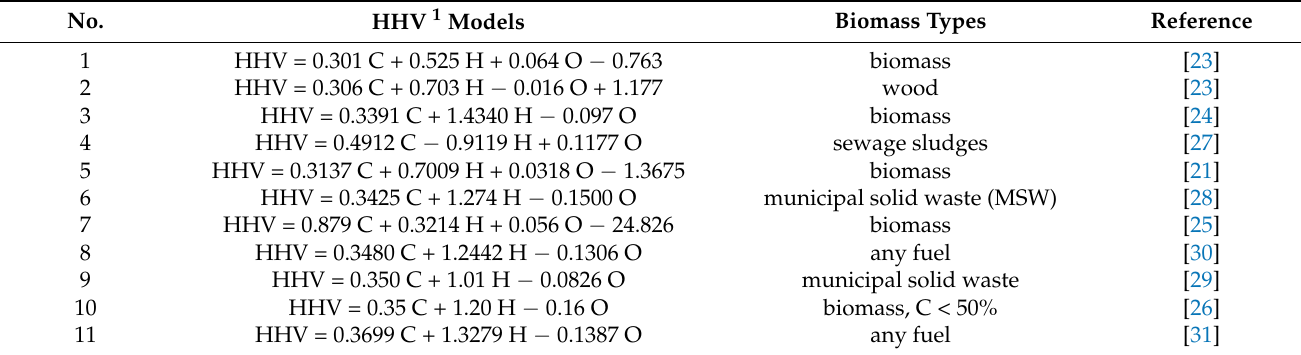
Table 1. Existing HHV models based on three major elements from the ultimate analysis for